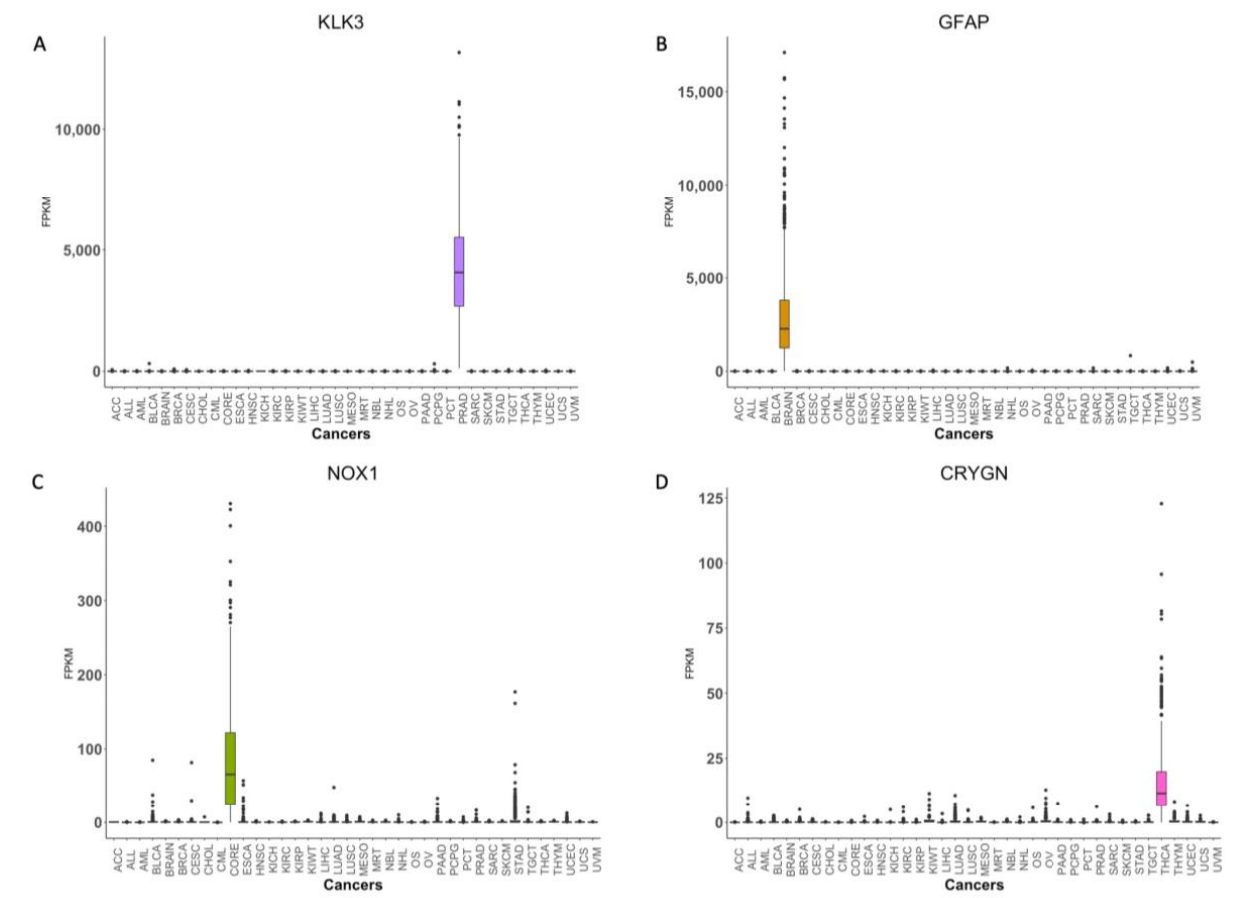
Figure 6. Representative examples of genes that exhibit cancer tissue-of-origin specific expression. Box-Whisker plots showing expression of ( A ) KLK3, ( B ) GFAP, ( C ) NOX1 and ( D ) CRYGN across 37 cancer types in TCGA data